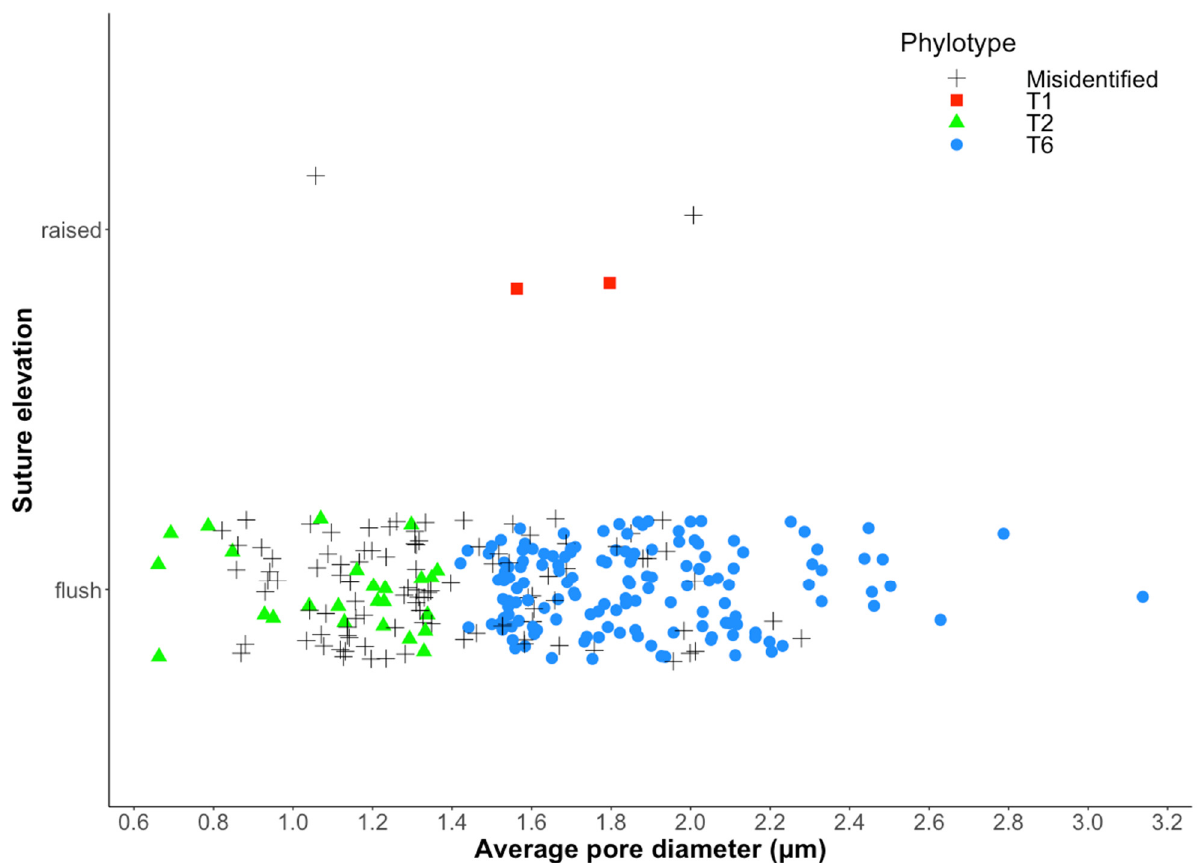
Figure 4. Suture elevation and average pore diameter for the correctly identified Ammonia T1 (red squares), T2 (green triangles), and T6 (blue circles) individuals. When there is a disagreement between SEM and stereomicroscope identifications, individuals are labeled as “misidentified” (black crosses).